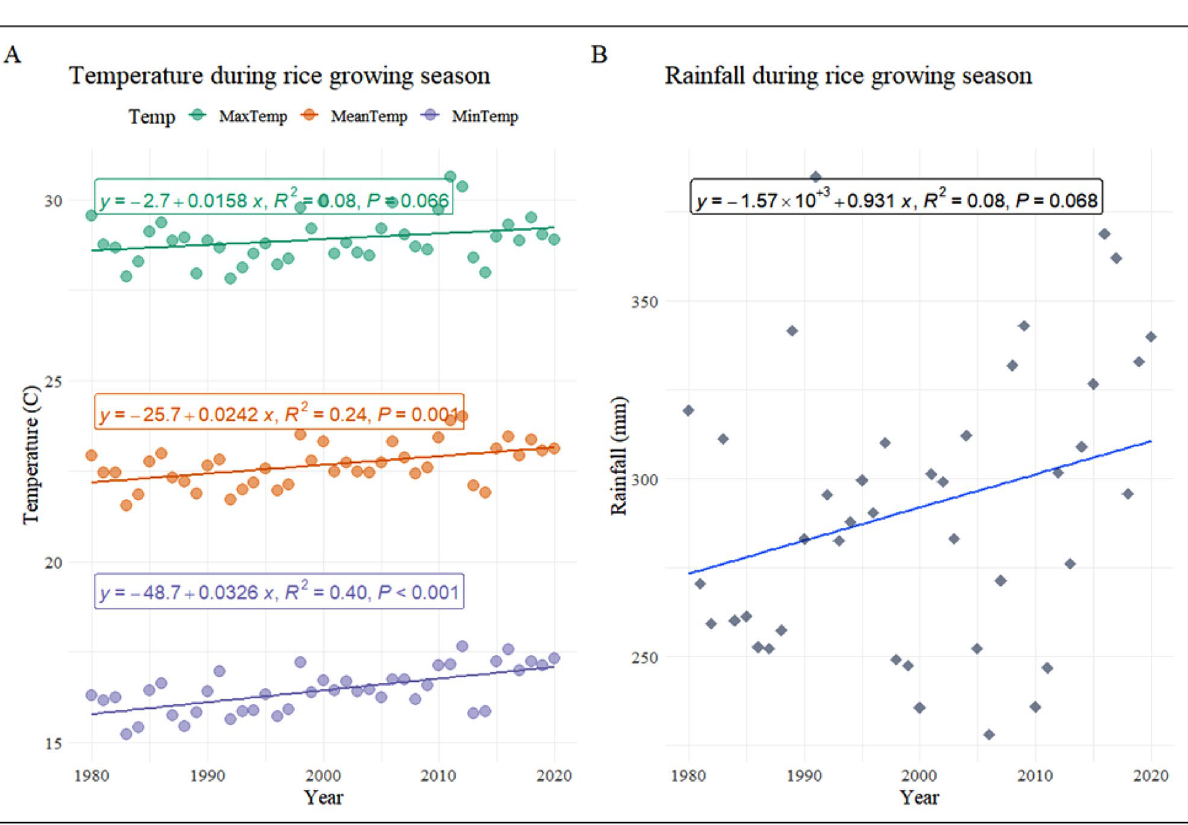
Figure 3. ( A ) T max showed a non-significant slope whereas T min , and T avg , showed significant slopes throughout RGS in the SE-US between 1980 and 2020. ( B ) The rainfall showed a non-significant trend in the SE-US over RGS between 1980 and